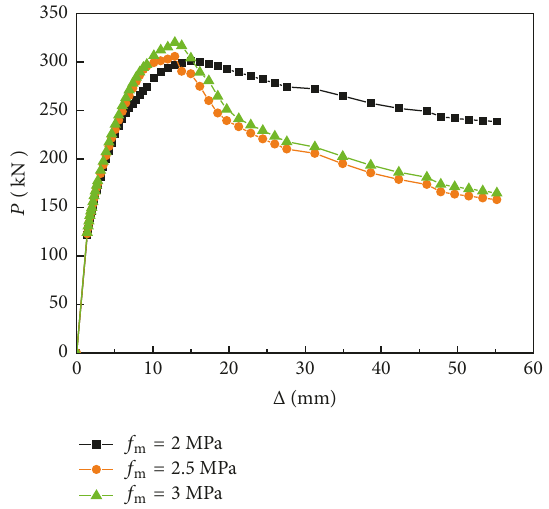
Figure 15: Calculated load-displacement